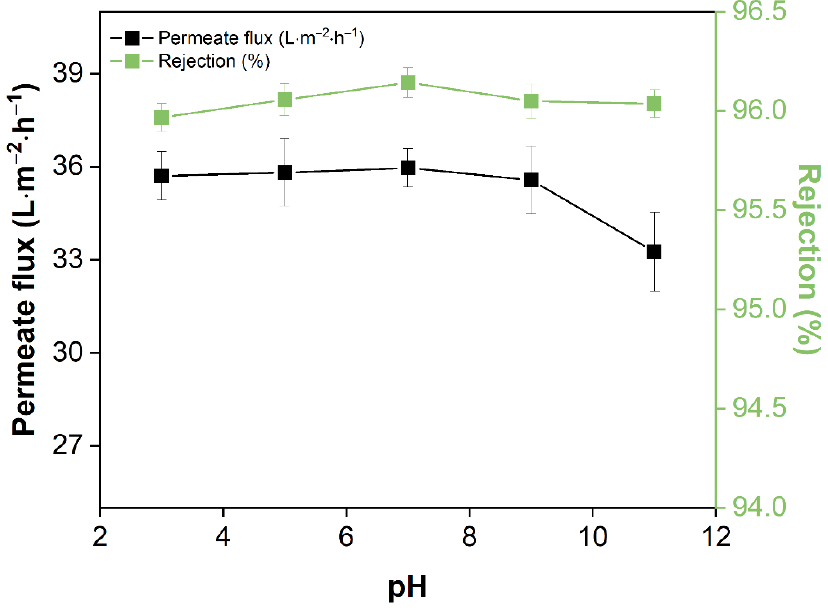
Figure 6. Permeate flux (black dot line) and rejection (green dot line) of RO membrane after 10 h running under different pH from 3 to 11. Operating conditions: feed solution, Na 2 SO 4 ; feed concen- tration, 2500 mg·L −1 ; feed flow rate, 35 L·h −1 ; operating pressure, 0.5 MPa; temperature, 18 °C.